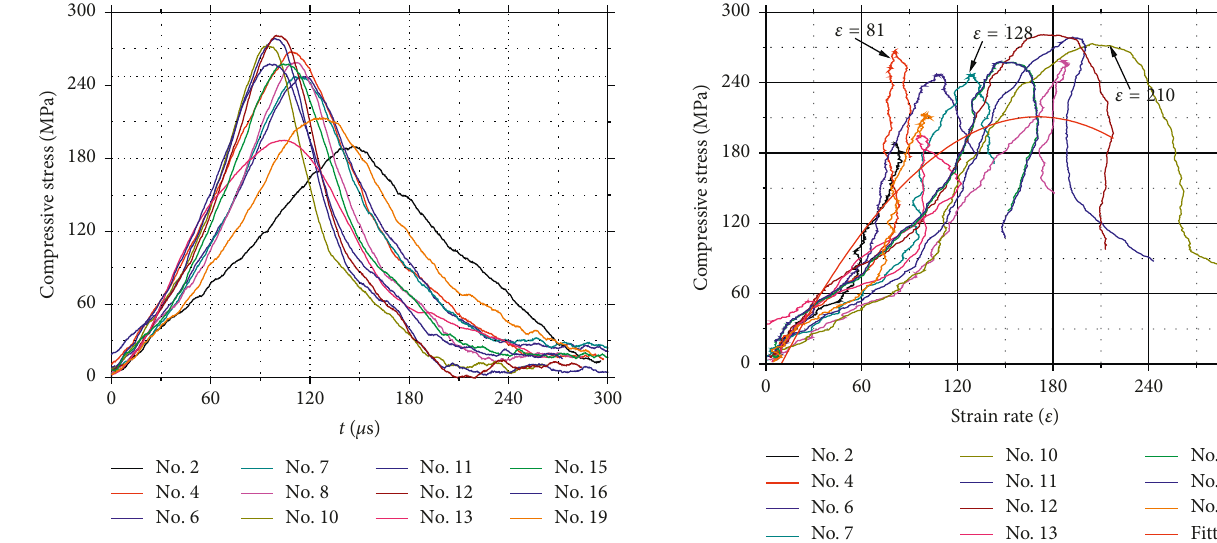
Figure 4: Dependence of the compression strength on time.